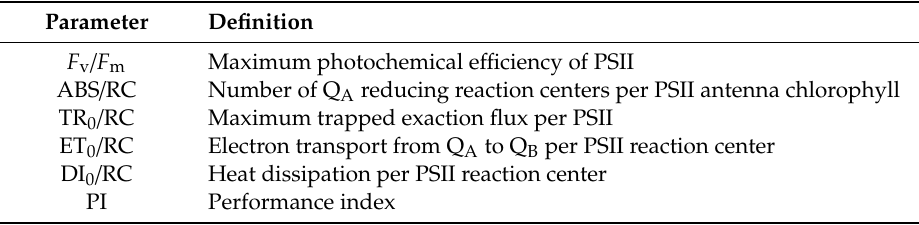
Table 1. The selected parameters of fluorescence